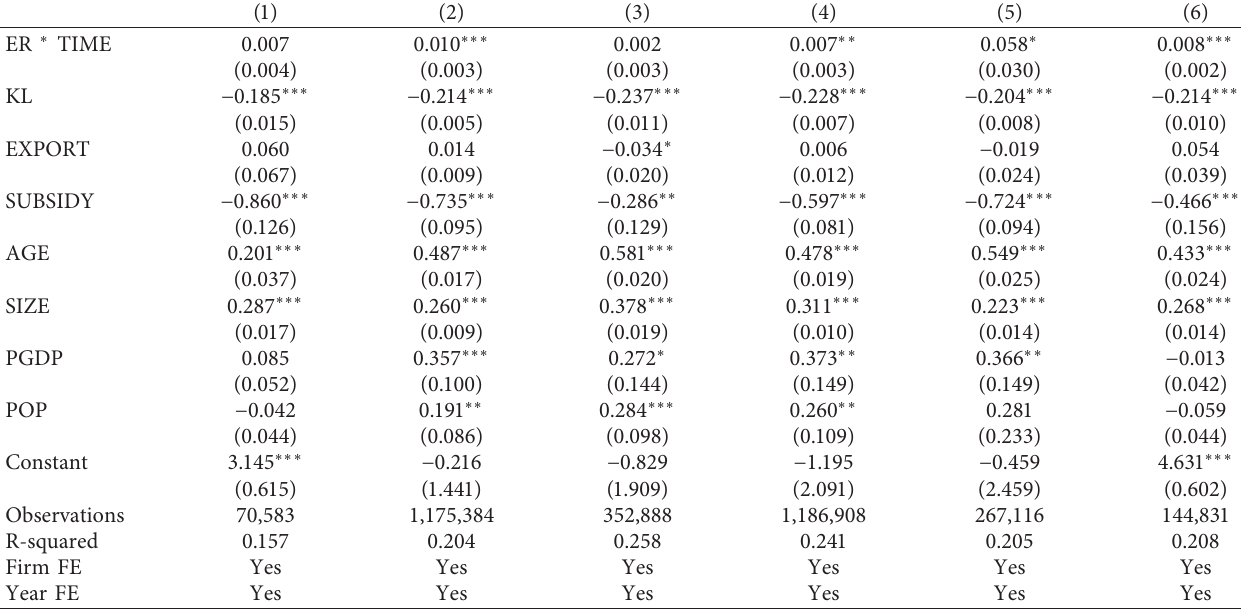
Table 7: Heterogeneity analysis